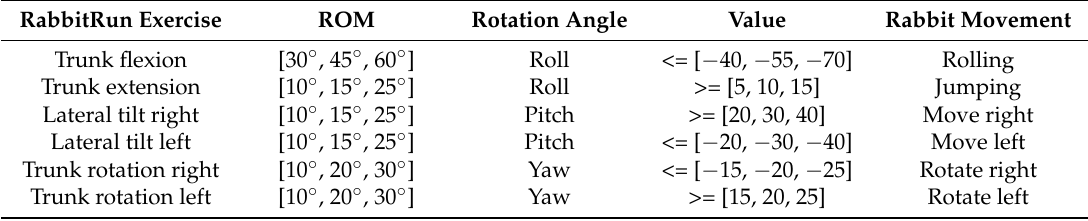
Table 3. The required range of motion (ROM) for each exercise for [level1, level2, level3], the name of the calculated rotational angle, the threshold values of the rotational angle that is required to move the rabbit for [level1, level2, level3] and the rabbit